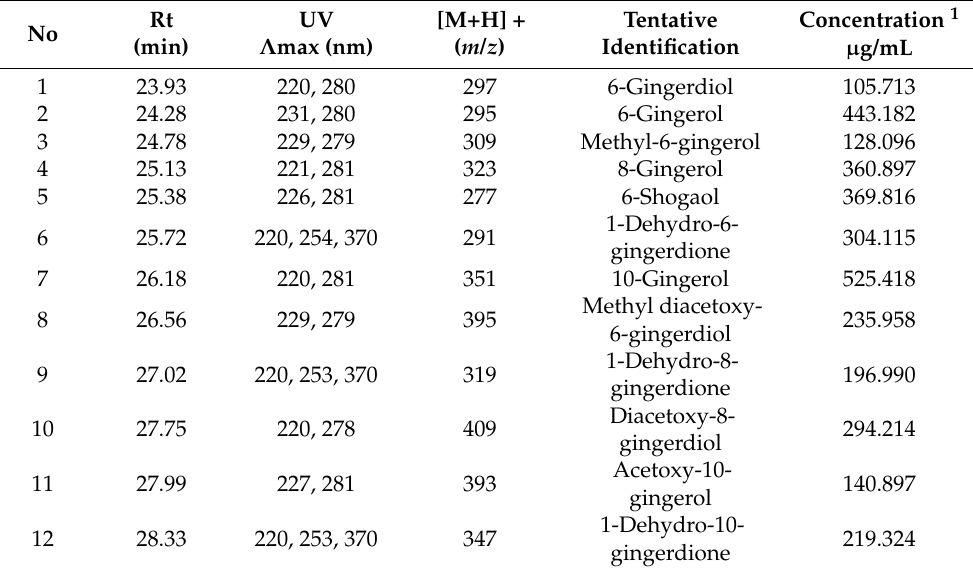
Figure 1. HPLC chromatogram of ginger root ethanol extract registered at 280 nm. The identification of the main compounds is listed in Table 3. Table 3. Identification and quantification of main compounds in the ginger root ethanol extract by HPLC-DAD-ESI MS.